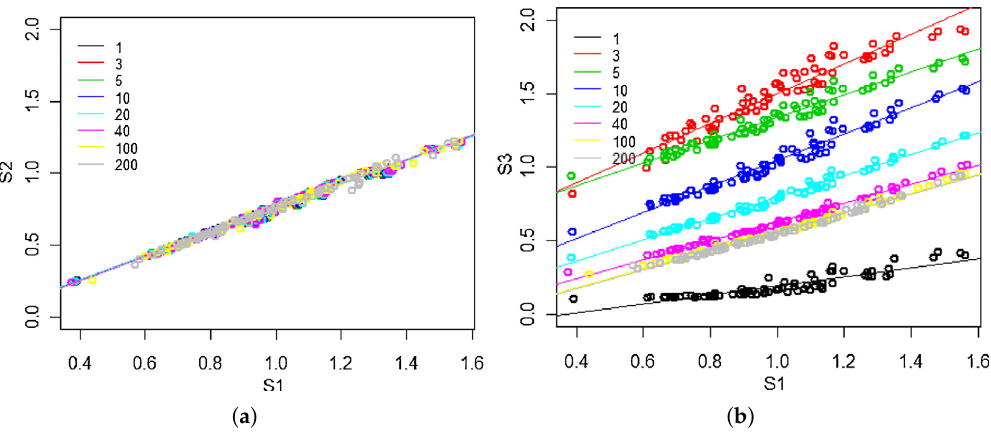
Figure 2. Correlations of data from three sensors of the same model. S1 and S2 are permanently powered, while S3 is the switched sensor. ( a ) S1 vs. S2 for n = 1,3,5,10,20,40,100,200 s. ( b ) S1 vs. S3 for n = 1,3,5,10,20,40,100,200 s. Taken from [14].